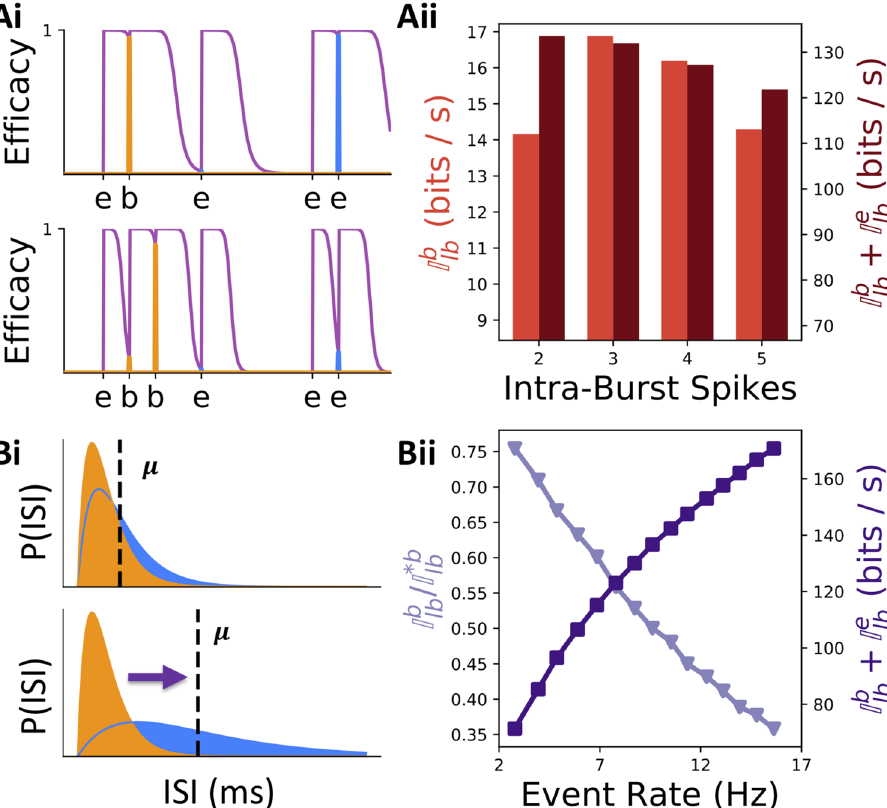
Figure 5. Effects of burst length and event rate on information transmission. ( Ai ) Illustration of the modulator- channel communication of a single hypothetical spike train made of a number of true events (‘e’ ticks) and bursts (‘b’ ticks) with IBIs comparable to IEIs (as in Fig. 4Aii, Bii). Top: for bursts made of 2 IB spikes, to communicate the burst implies that an event with a similar interval (last event) will also be communicated. Bottom: using bursts made of 3 IB spikes (orange) allows the burst to be transmitted while minimizing transmission from the last event because the synaptic efficacy is allowed to accumulate through successive IBIs. ( Aii ) Modulator channel information rate (left y-axis) and total information rate (right y-axis) are shown as a function of the number of intra-burst spikes. ( Bi ) Schematic illustration of how the overlap between a fixed IBI distribution (orange) and the IEI distribution depends on whether the average IEI ( µ , dashed line) is short (top) or long (bottom). Bii Normalized burst channel decoding efficacy (left y-axis, light purple down-arrowheads) monotonically decreases, with increasing average event rate, while the total burst multiplexing information (right y-axis, dark purple squares) increases. Both Aii and Bii were generated using strongly unimodal ISI distributions ( τ rel = 2